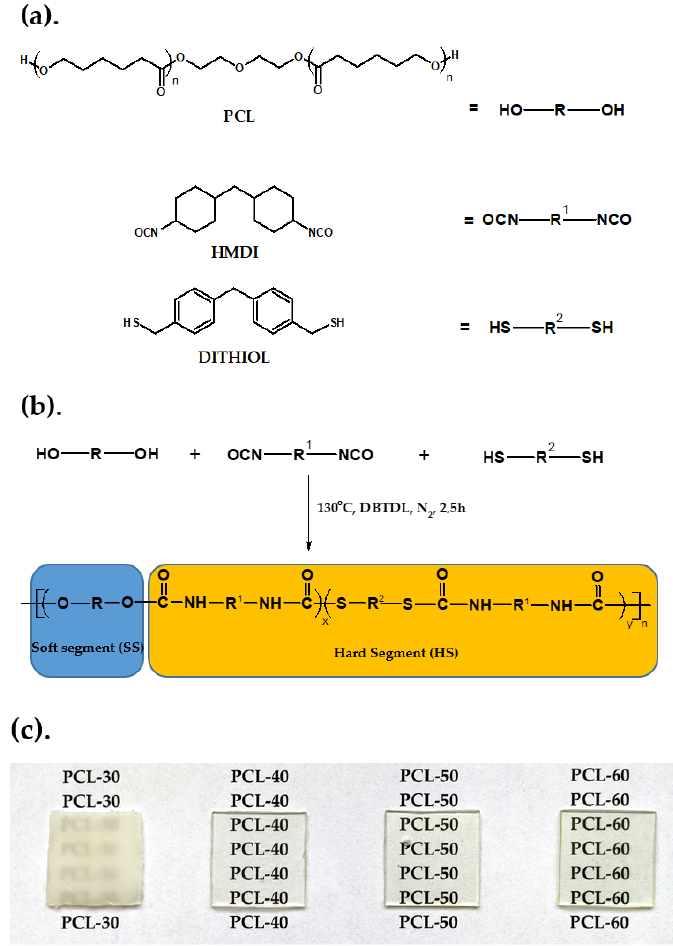
Figure 1. ( a ) Chemical structures of the reactants, ( b ) schematic representation of the synthesis route of polymers, ( c ) images of the synthesized polymers.